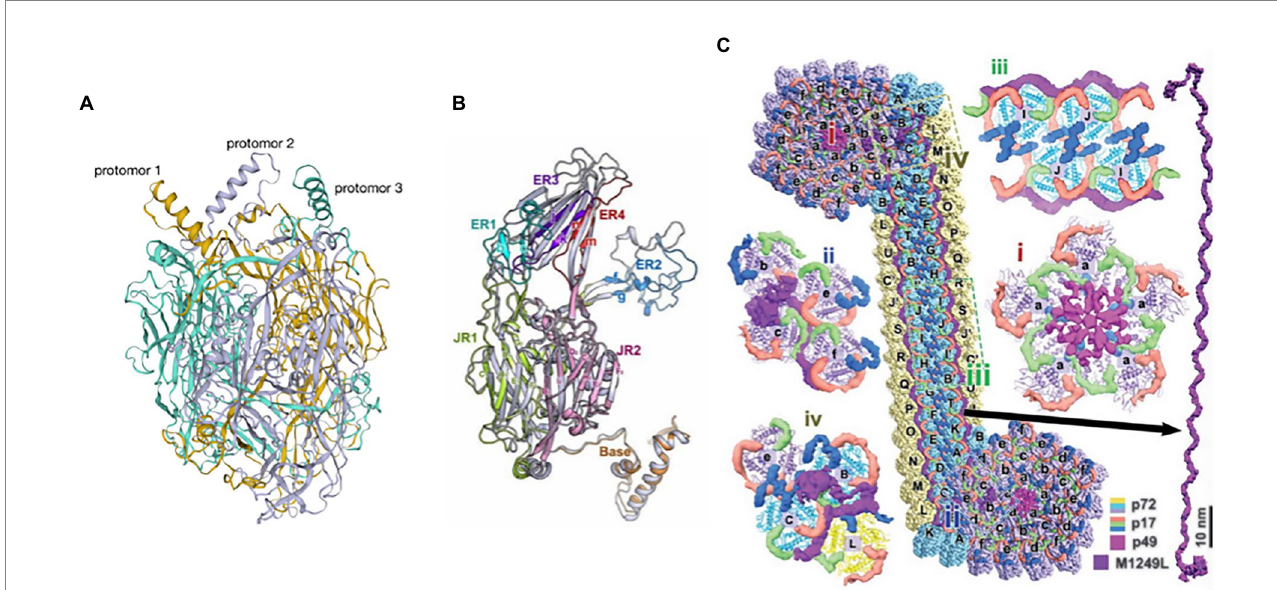
FIGURE 8 (A) The trimeric structure of the p72 protein (Wang et al., 2019). Deep yellow: protomer 1; lavender: protomer 2; cyan: protomer 3. (B) Diagram of the p72 monomer. The domains base, JR1 (jelly roll 1), JR2 (jelly roll 2), and ER1 to ER4 are shown (Wang et al., 2019). (C) Diagram of the interaction of p72 with H240R, M1249L, p17, and p49 (Wang et al.,